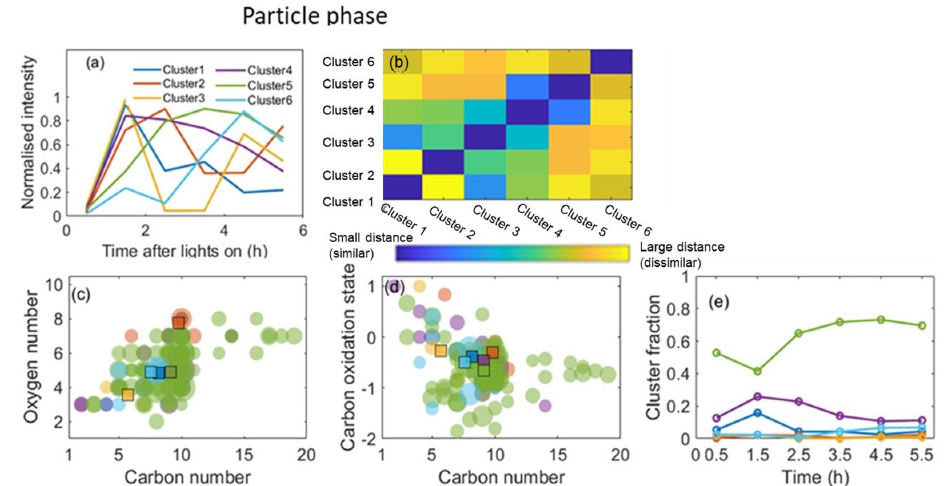
Figure 6. Hierarchical clustering of particle-phase oxidation products for the representative α -pinene system. (a) Average time series of each cluster normalized to the highest ion intensity between 0 and 1. (b) Matrix showing the relative distance between clusters. (c) Carbon number vs. oxygen number for each cluster. (d) Carbon number vs. oxidation state for each cluster. (e) Time series of the sum of ions’ normalized signal fractions to the total signal in each cluster. Note that the square symbols represent the contribution of weighted-average carbon numbers, oxygen numbers, and/or OS C in each cluster. The colours correspond to the ones in panel (a) .